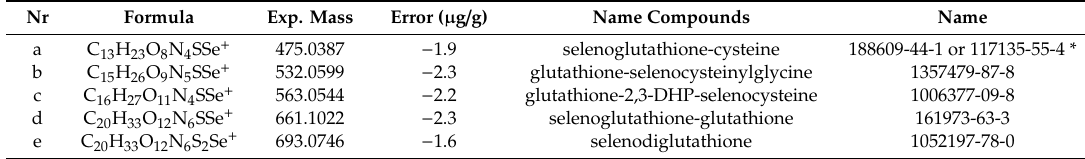
Table 4. Selenium species identified in the water soluble fraction of Candida yeast.